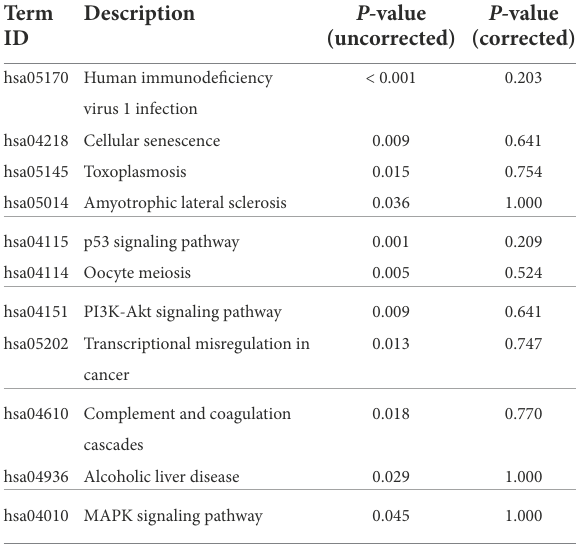
TABLE 3 Pathway enrichment analysis revealed 11 significantly enriched pathways.